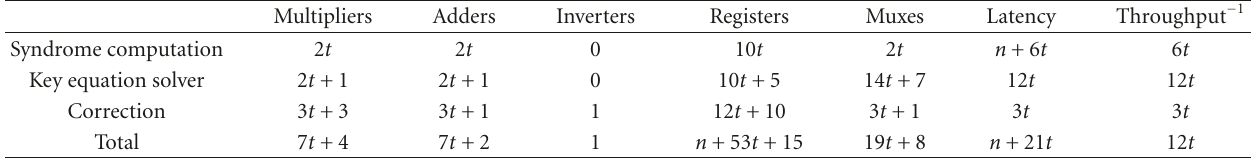
Table 3: Decoder architecture based on syndrome-based decoding (CPD is T mult + T add + T mux ) Multipliers